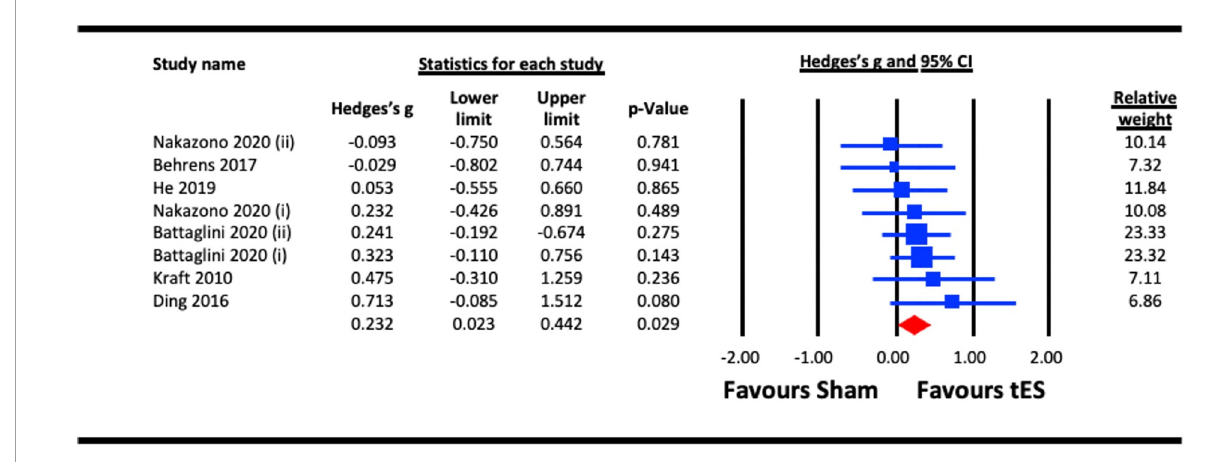
FIGURE2 Acute effect of transcranial electrical stimulation (tES) [anodal-transcranial direct current stimulation (a-tDCS), transcranial random noise stimulation (tRNS), and transcranial alternating current stimulation (tACS)] on contrast sensitivity. Meta-analyses for Nakazono (2020) were separated for data on 9.0 cpd alpha (acute) and 9.0 cpd beta (acute), represented as Nakazono (2020) (i) and Nakazono (2020) (ii) Meta analyses for Battaglini (2020a) were separated for data using contrast stimuli of 45 ◦ and vertical, represented as Battaglini (2020a) (i) and Battaglini (2020a) (ii).